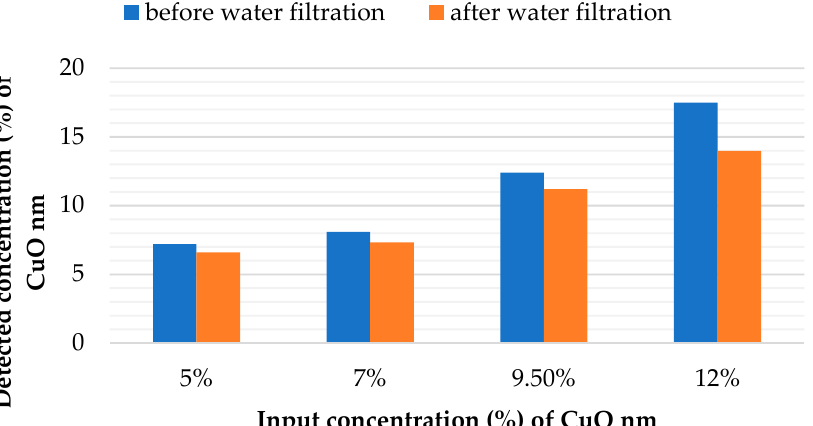
Figure 10. Content of nanoparticles of CuO on the nanofiber surface before and after treatment under the simulated conditions of water filtration according to the results of EDX analysis (experiments with the rotating needle electrode).